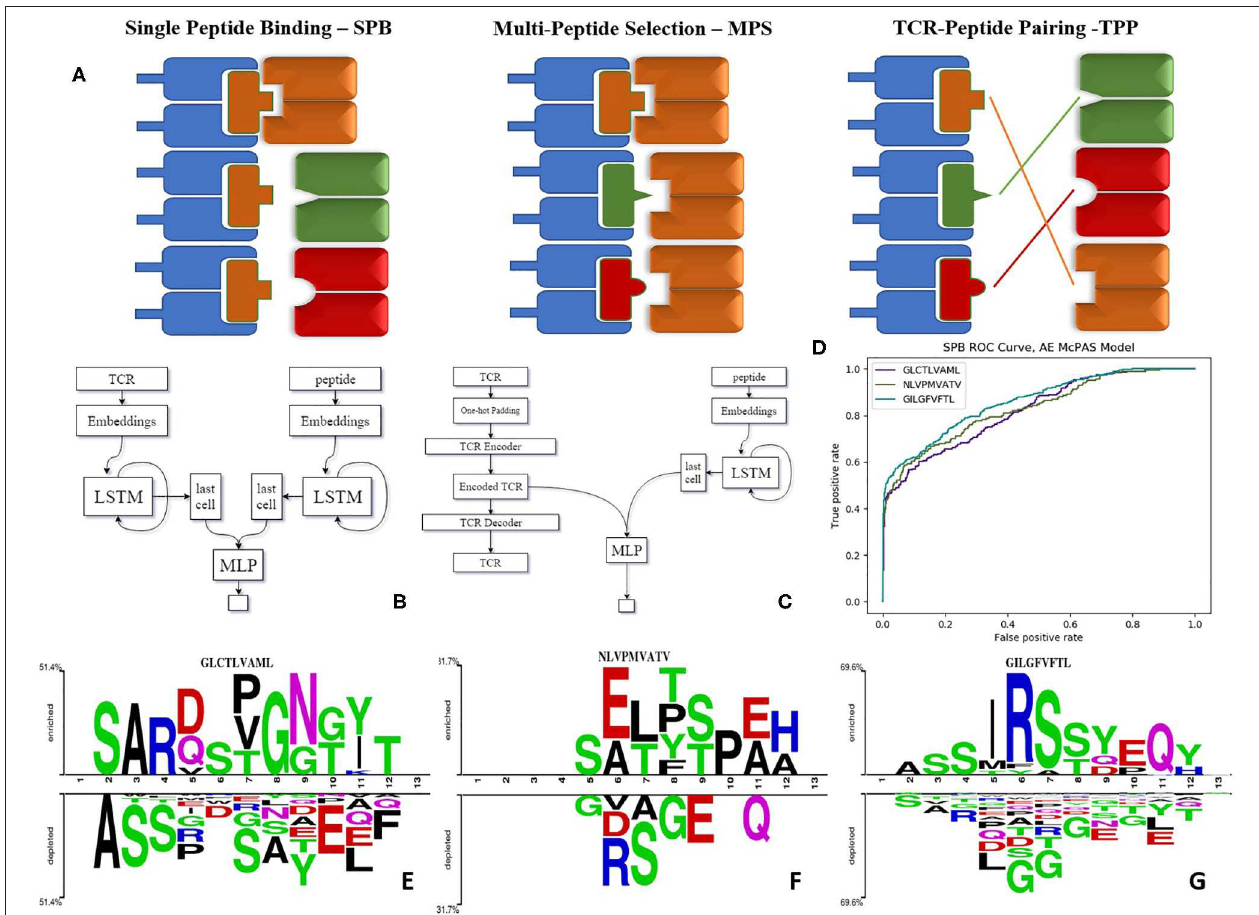
FIGURE 1 | (A) Illustration of the tests we suggest for evaluating the model performance as explained—SPB, single peptide binding; MPS, multi-peptide selection; and TPP, TCR-peptide pairing. (B) LSTM based model architecture. (C) Autoencoder based model architecture. (D) ROC curve of autoencoder based model SPB performance on 3 human peptides from Dash et al. (18) dataset. (E–G) Comparison of amino acids of CDR3 beta sequences of TCRs binding Dash et al. (18) peptides vs. TCRs that do not bind these peptides, in McPAS (23) database (logos were created with Two-Sample-Logos); the height of symbols within the stack in each logo indicates the relative frequency of each amino acid at that position. Only amino acids whose distribution differs significantly between the two sets are shown, and only 13 length TCRs were